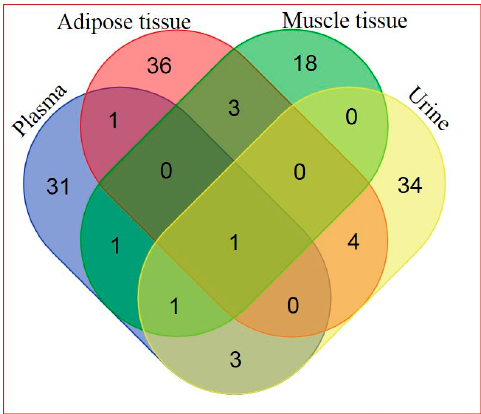
Figure 2. Venn diagram of significantly hRSV-altered metabolites detected in the four different matrices (for metabolite details see Supplementary Table S6).